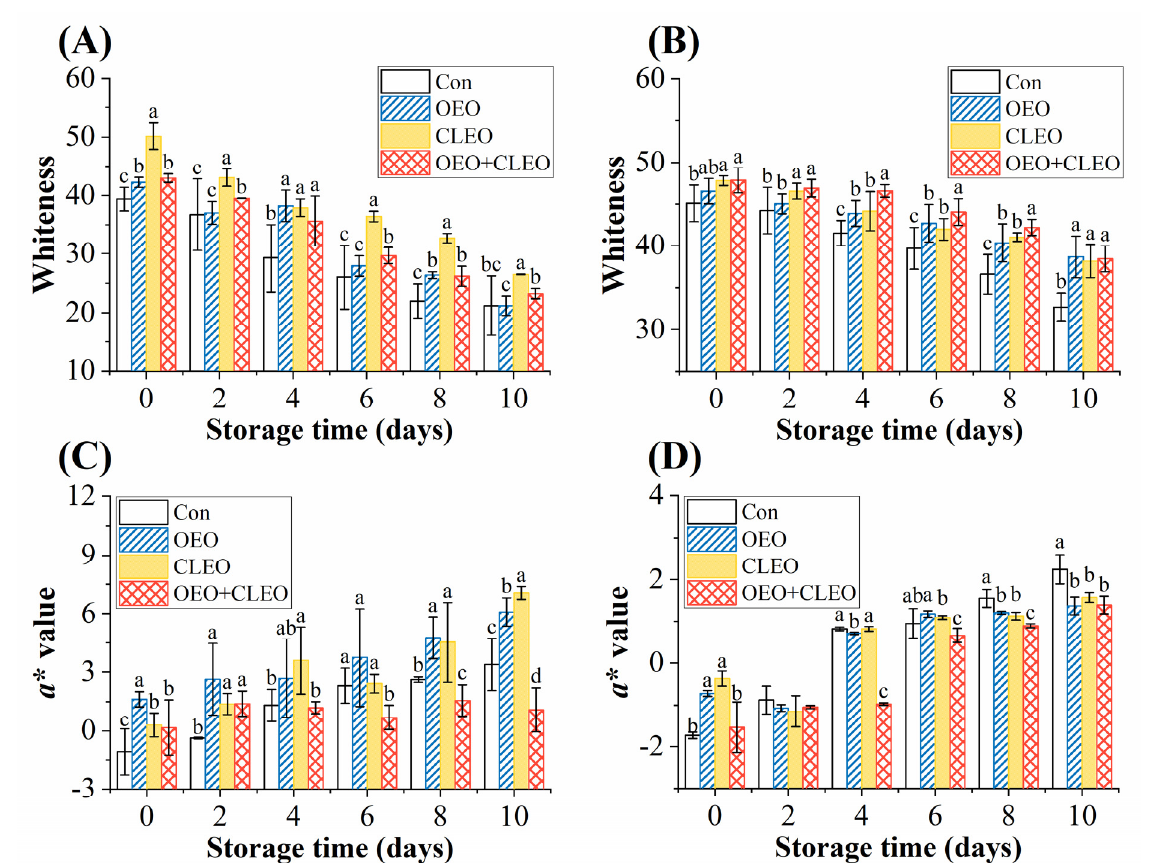
Figure 3. Changes of whiteness and a * of cephalothorax ( A , C ) and abdomen ( B , D ) of refrigerated Pacific white shrimp treated with OEO and CLEO at 4 °C. Data are shown as mean ± SD (n = 3). Note: Different lowercase letters indicate significant differences ( p < 0.05) among different treatments within the same storage time.